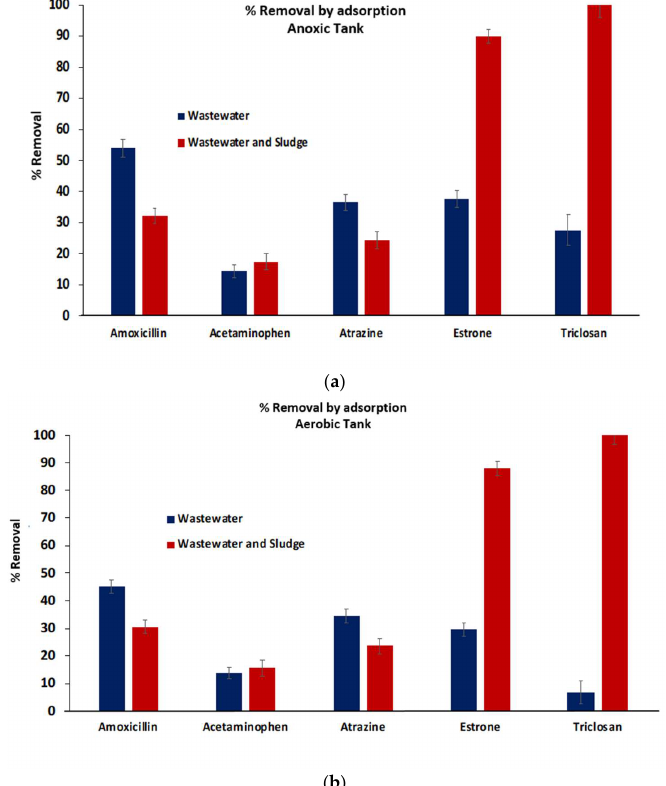
Figure 6. Percentage removal of the micropollutants by adsorption in the 10 L volume of wastewater (blue) and wastewater with sludge (red) in anoxic ( a ) and aerobic ( b ) tanks respectively.